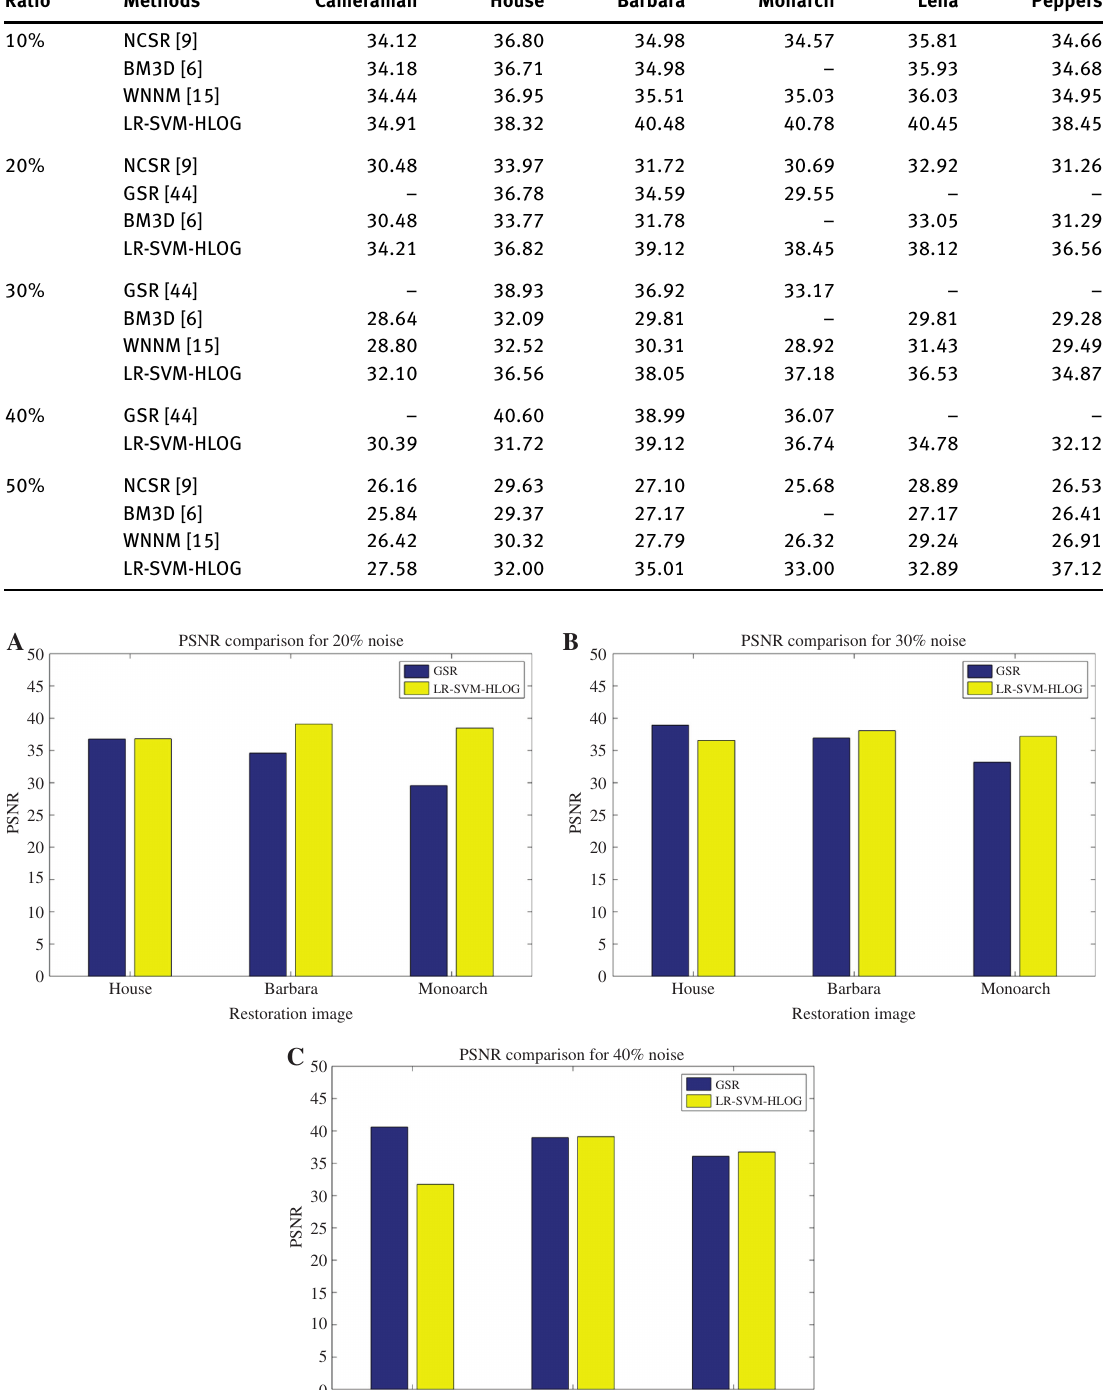
Table 4: Comparative Analysis for Grayscale Images.